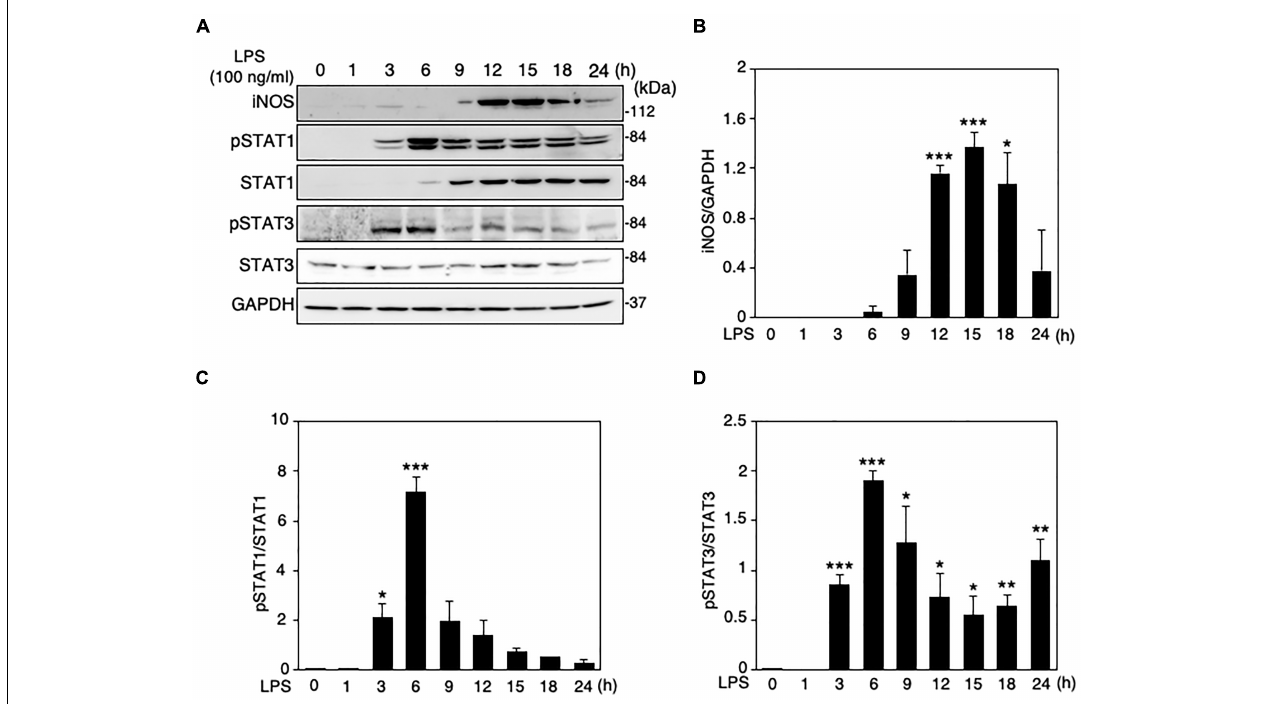
FIGURE 1 | Changes in protein expression levels of iNOS and total and phosphorylation levels of STAT1 and STAT3 in LPS-stimulated MG6 cells. (A) Typical Western blots of iNOS, phospho-STAT1 at Tyr-701, total STAT-1, phospho-STAT3 at Tyr-705, and total STAT-3 after challenge with 100 ng/ml LPS. GAPDH served as loading control. (B) Time course of changes in iNOS protein expression after LPS application. (C) Time course of changes in STAT1 phosphorylation after LPS application. (D) Time course of changes in STAT3 phosphorylation after LPS application. The results represent the mean ± SEM for three independent experiments. ∗ P < 0.05, ∗∗ P < 0.01, and ∗∗∗ P < 0.001 vs. time 0 by t